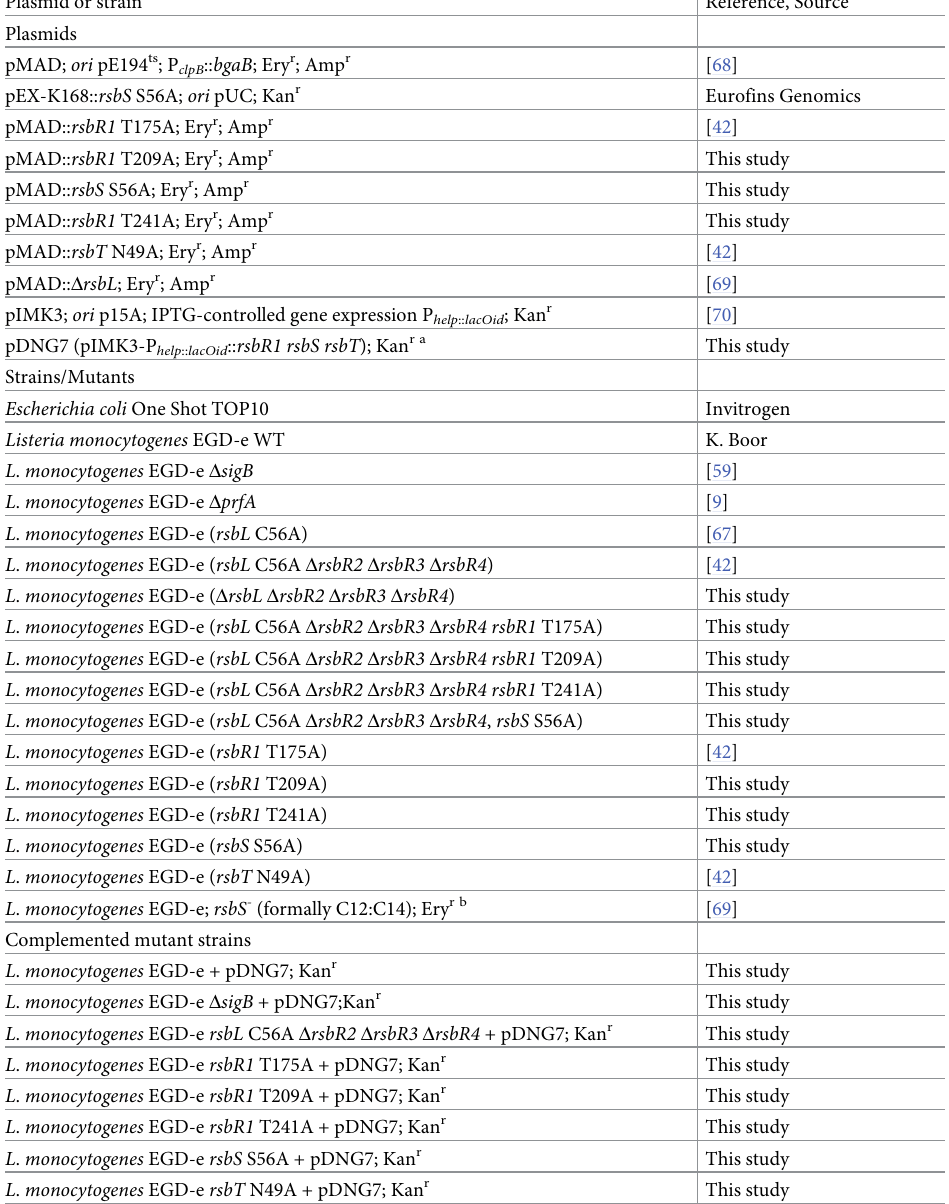
Table 1. Plasmids and strains used in this study. Plasmid or strain Reference, Source